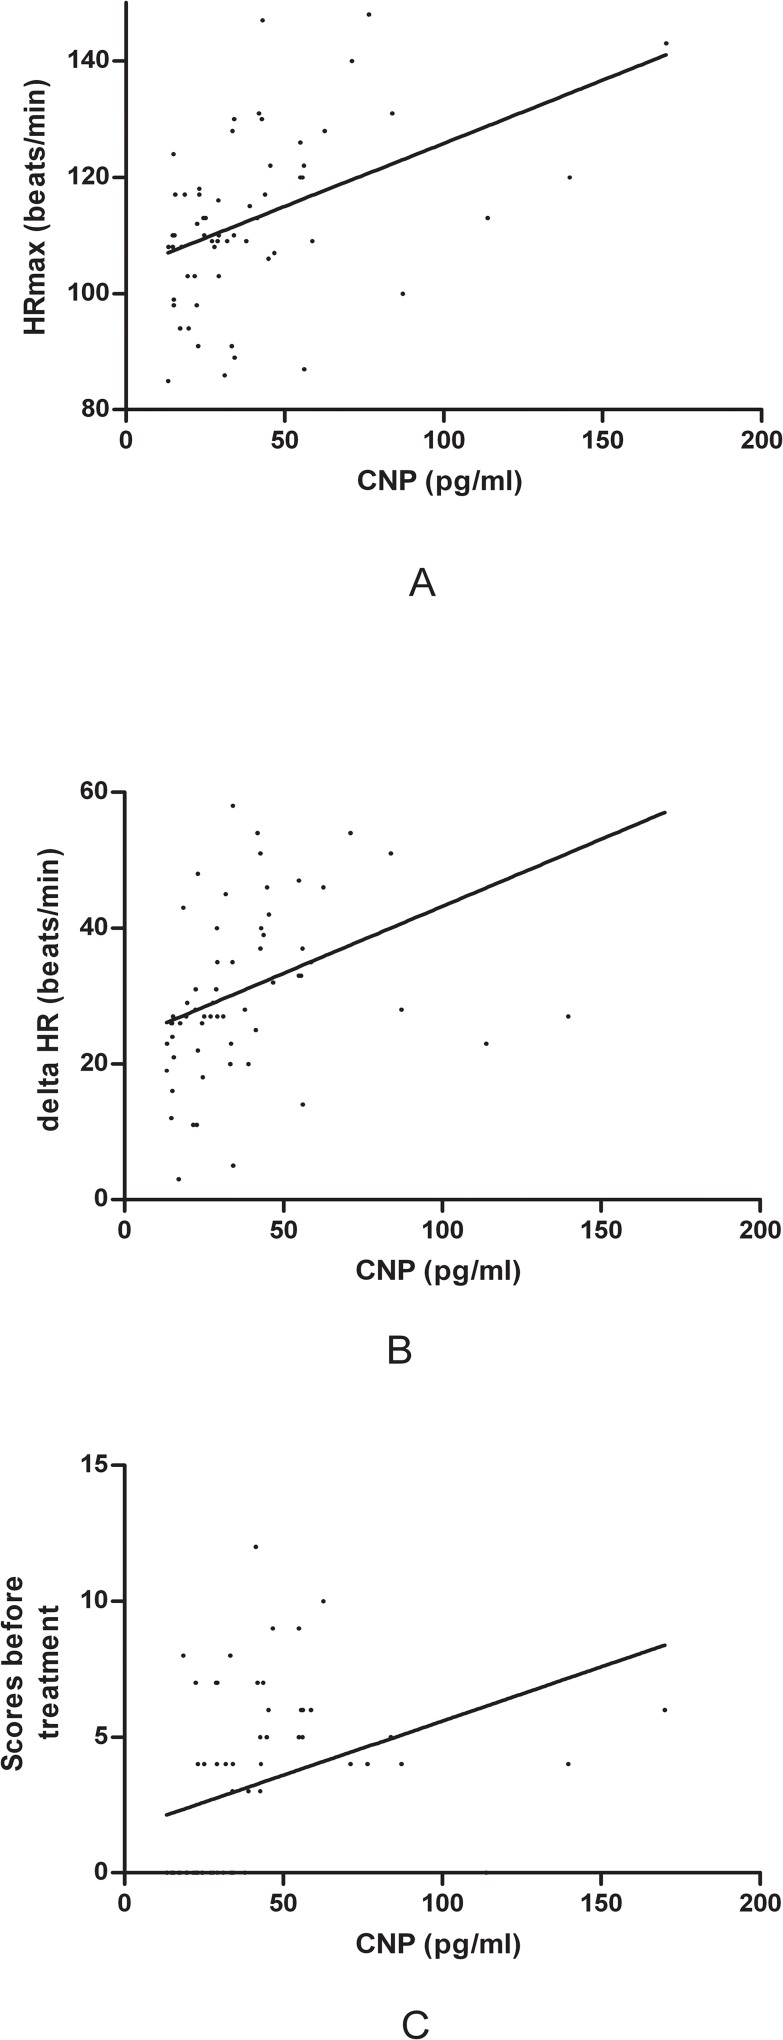
Linear correlation of plasma CNP with the upright maximum heart rate, increased heart rate from supine to upright and symptom scores.A: concentration of CNP was positively correlated with the upright maximum heart rate. Correlation coefficient r = 0.445, r2 = 0.20, (P < 0.001); B: concentration of plasma CNP was positively associated with increased value of heart rate from supine to upright. Correlation coefficient r = 0.434, r2 = 0.19, (P < 0.001); C: concentration of plasma CNP was positively correlated with symptom scores. Correlation coefficient r = 0.361, r2 = 0.13, (P < 0.01)